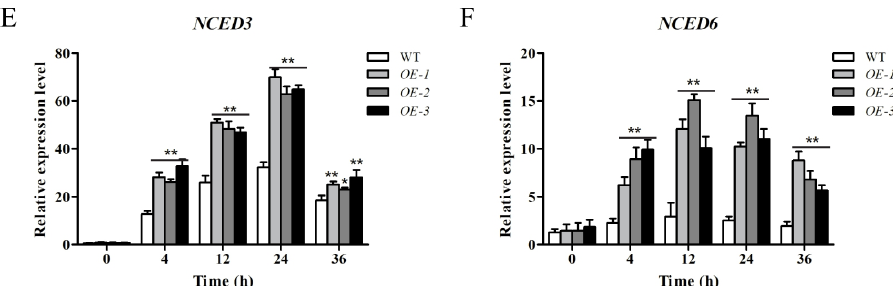
Figure 7. The relative expression of stress-related genes. ( A ) RD29A , ( B ) HSP90 , ( C ) DREB2A , ( D ) CuZnSOD , ( E ) NCED3 , and ( F ) NCED6 were examined under control and drought conditions for various time points (4, 12, 24 and 36 h). Values are means ± SDs of three replicates, and asterisks (* or **) represent the significant differences at p < 0.05 or p < 0.01, respectively (Student’s t -test).